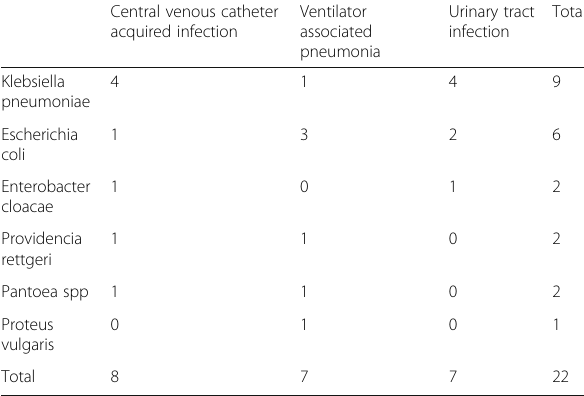
Table 1 (abstract 0177). Type of nosocomial infection according to the responsible